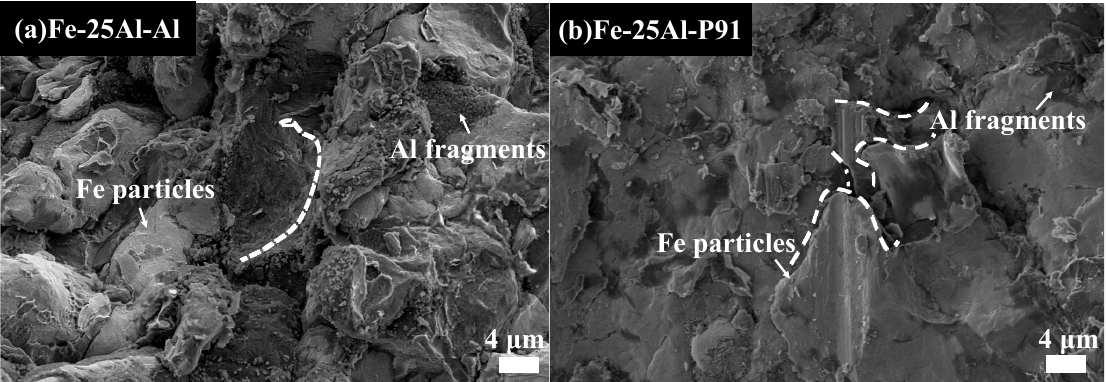
Figure 8. SEM images of the fracture morphology along the inter ‐ particle interface of Fe ‐ 25Al ‐ Al and Fe ‐ 25Al ‐ P91.